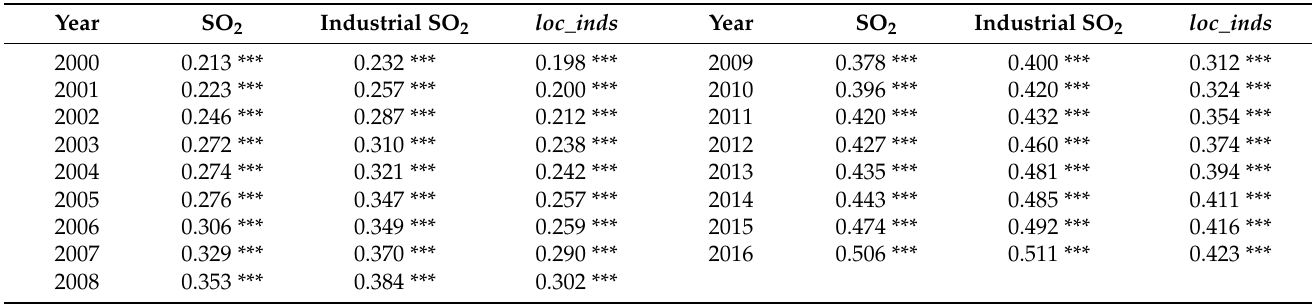
Table 1. Moran’s Index of the Location Quotient of the Air Pollution and